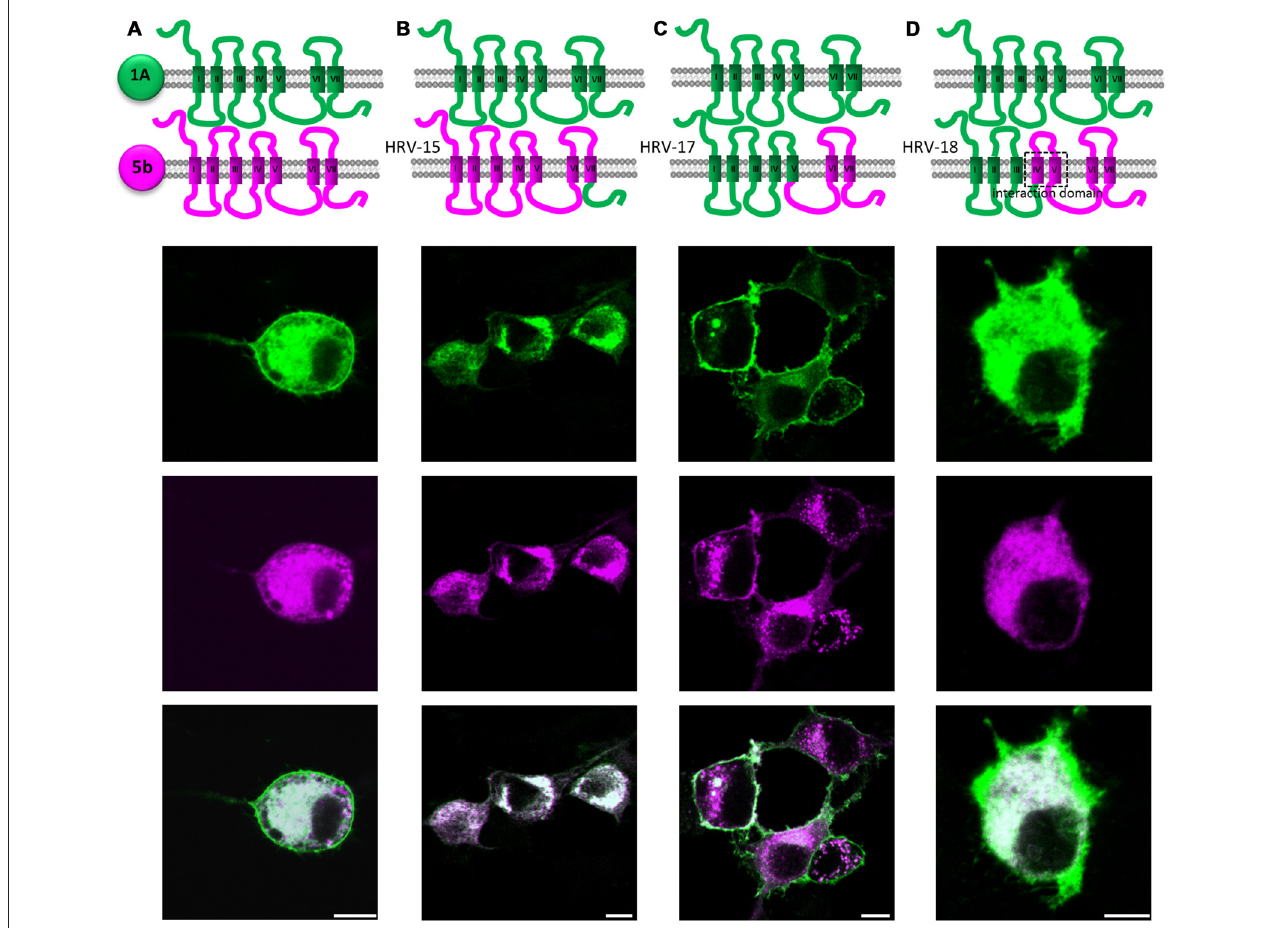
FIGURE 6 | Identification of possible interaction domains between 5-HT 1A (green) and 5-ht 5b (purple). N1E-115 cells were transiently transfected with two hybrid receptor variants labeled with eGFP or mCherry. (A) Co-expression of full length 5-HT 1A and full length 5-ht 5b lead to strong internalization of 5-HT 1A . (B) Replacing the C-terminal domain of 5-ht 5b with the C-terminal domain of 5-HT 1A (HRV-15) did not change the amount of interaction. (C) Expressing 5-HT 1A together with a hybrid